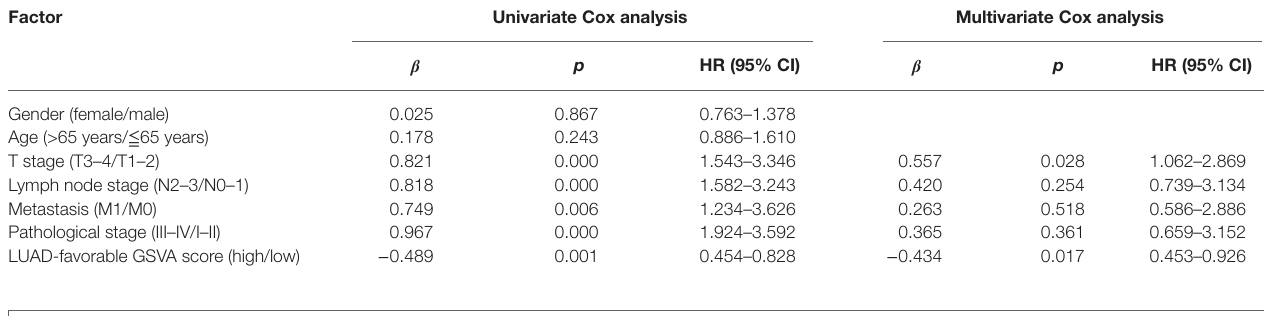
TABLE 3 | Univariate and multivariate analyses of LUAD-favorable GSVA score.